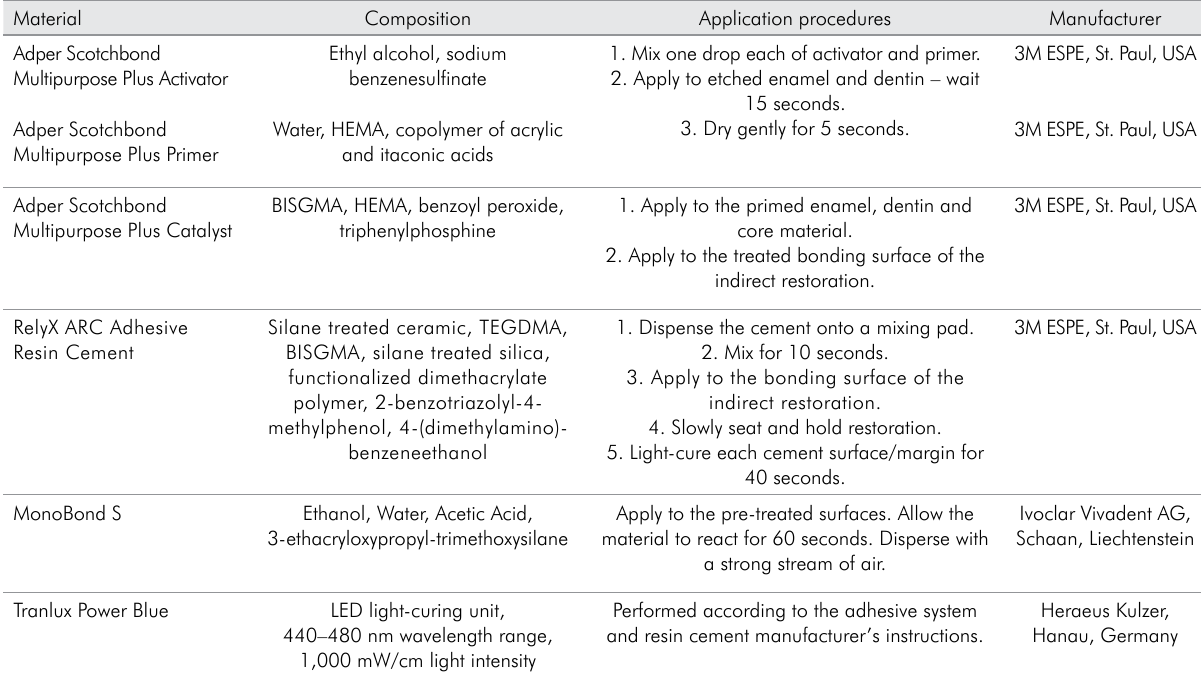
table 1. Adhesive system, resin cement and silane used, together with ingredients and application procedures, accord- ing to the